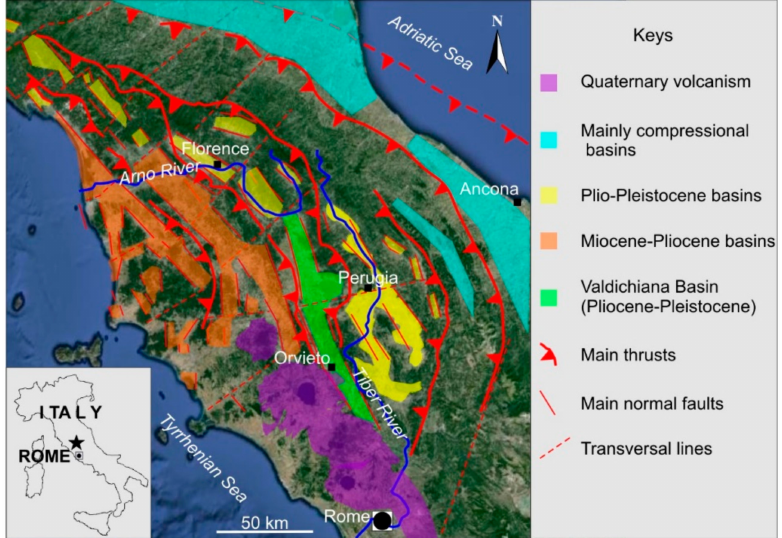
Figure 1. Miocene to Pleistocene basins in Northern Apennines [4,7] (redrawn and